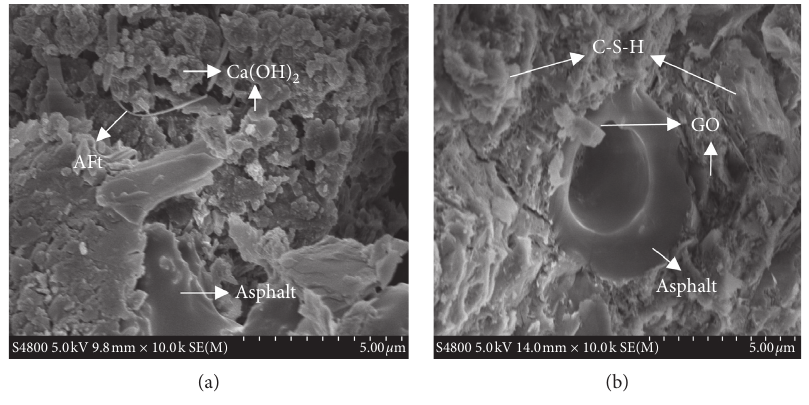
Figure 11: ESEM pictures of CEAP: (a) without GO and (b) with GO.